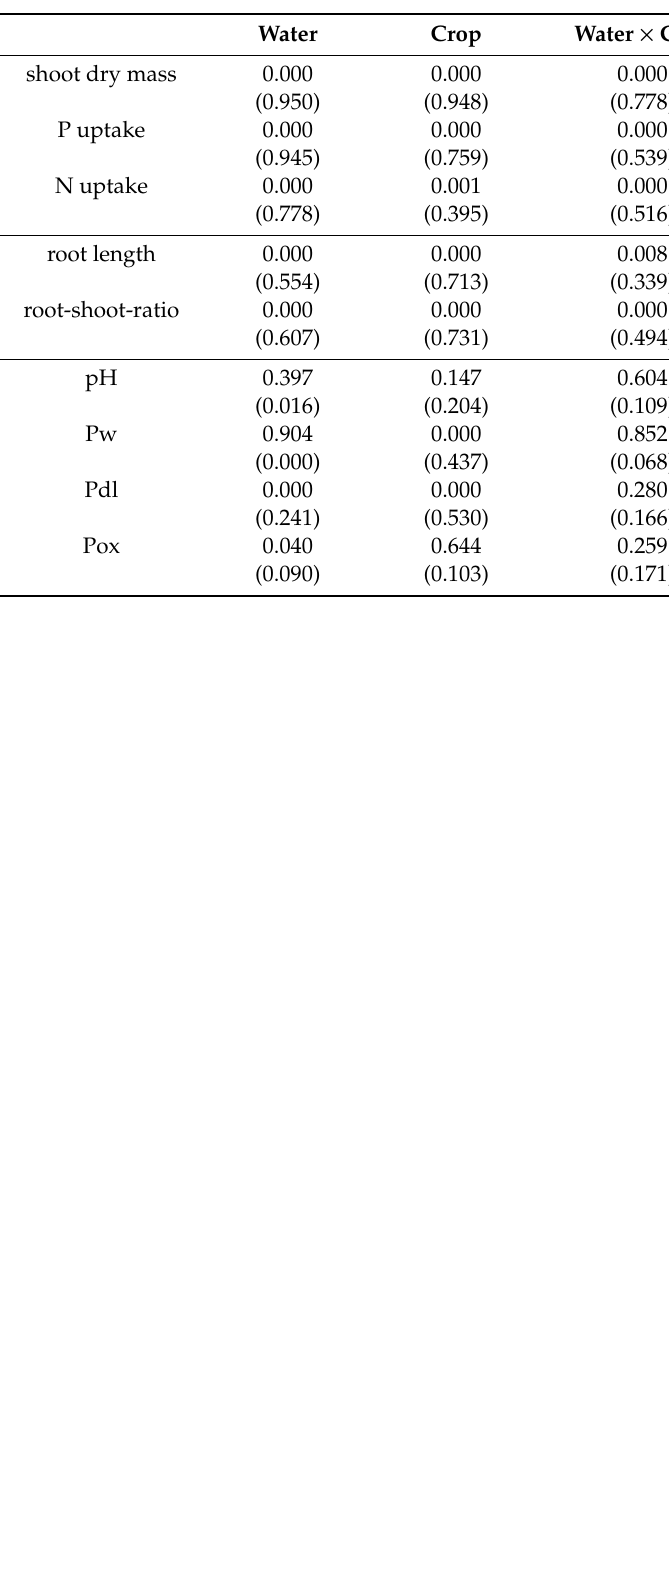
Table A1. Single and interactive e ff ects of water supply and cropping (ANOVA, p -values and e ff ect size (eta 2 in brackets) in the